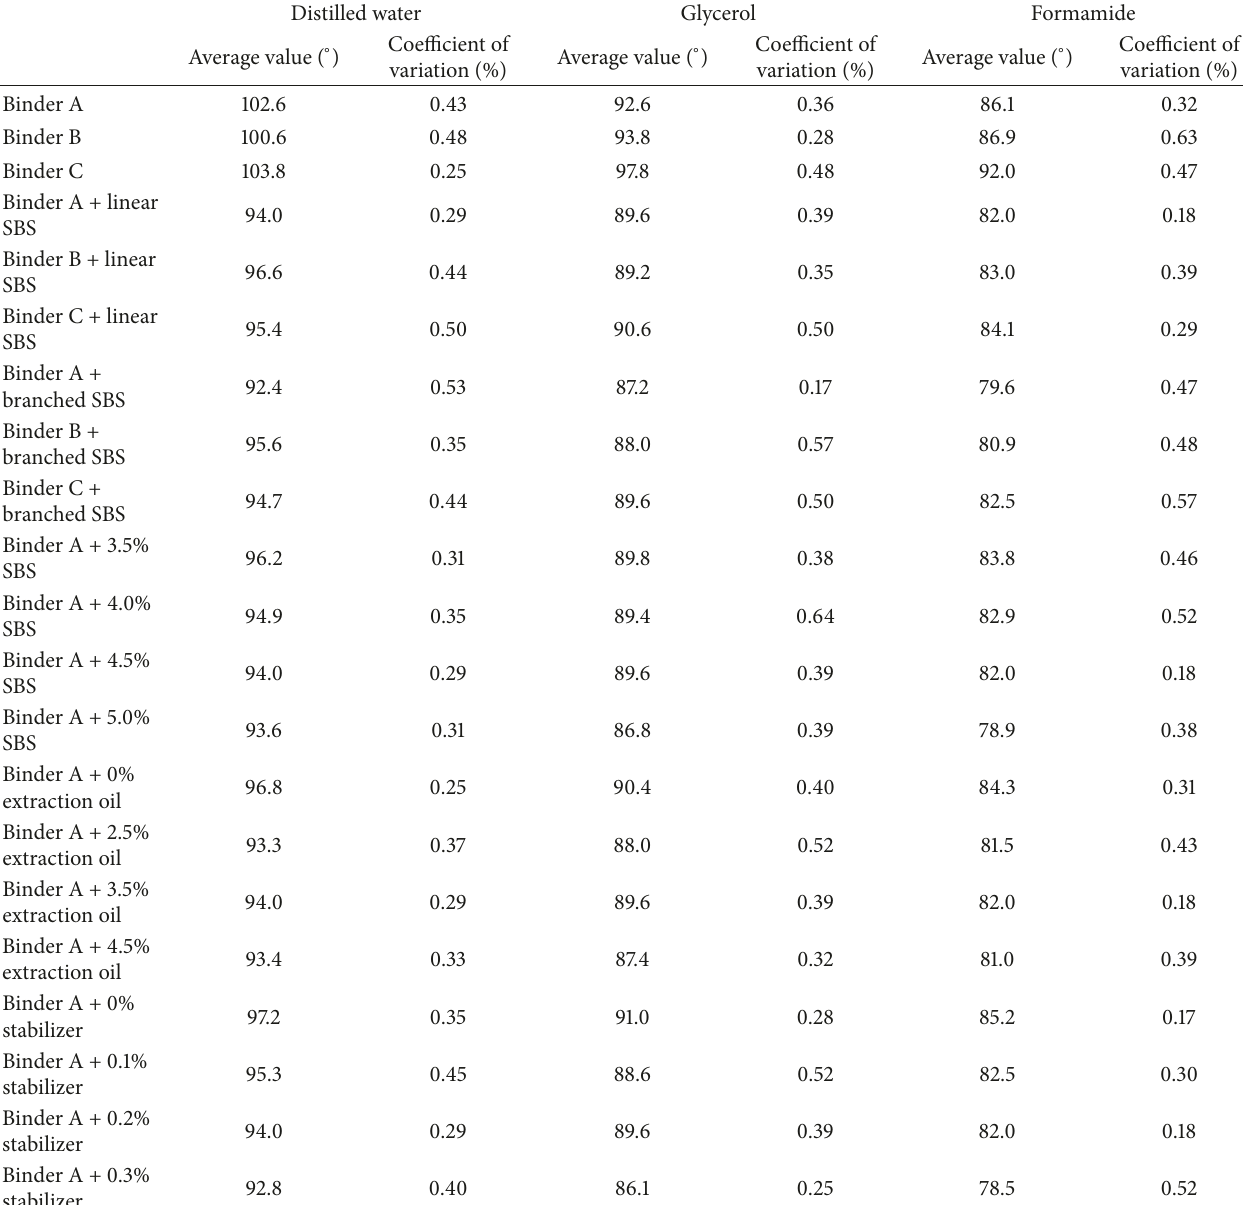
Table 6: Contact angle and its variation coefficient for the SBS-modified